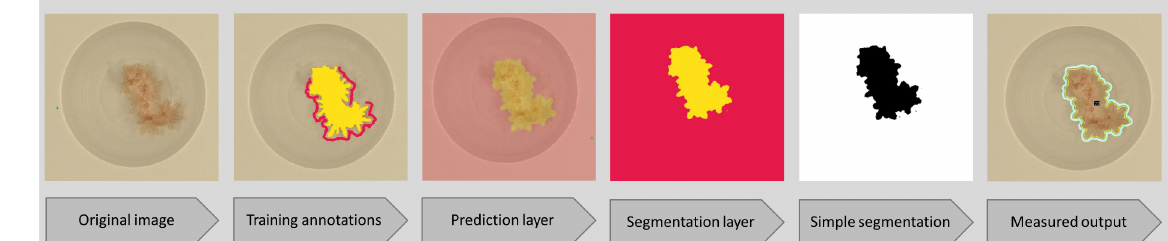
Figure 2. Infographic showing the evolution of images through the machine learning image analysis pipeline. The sequence includes: the original image, training annotations, the produced prediction layer, and uncertainty layer signalling areas that require further training. After training, the final segmentation layer shows the outline of the juvenile with precise boundaries. This is then converted into a simple segmentation mask, which uses grey scale for each classification label. The final image shows the juvenile after being labelled with a unique identifier and outlined to show the area measured.